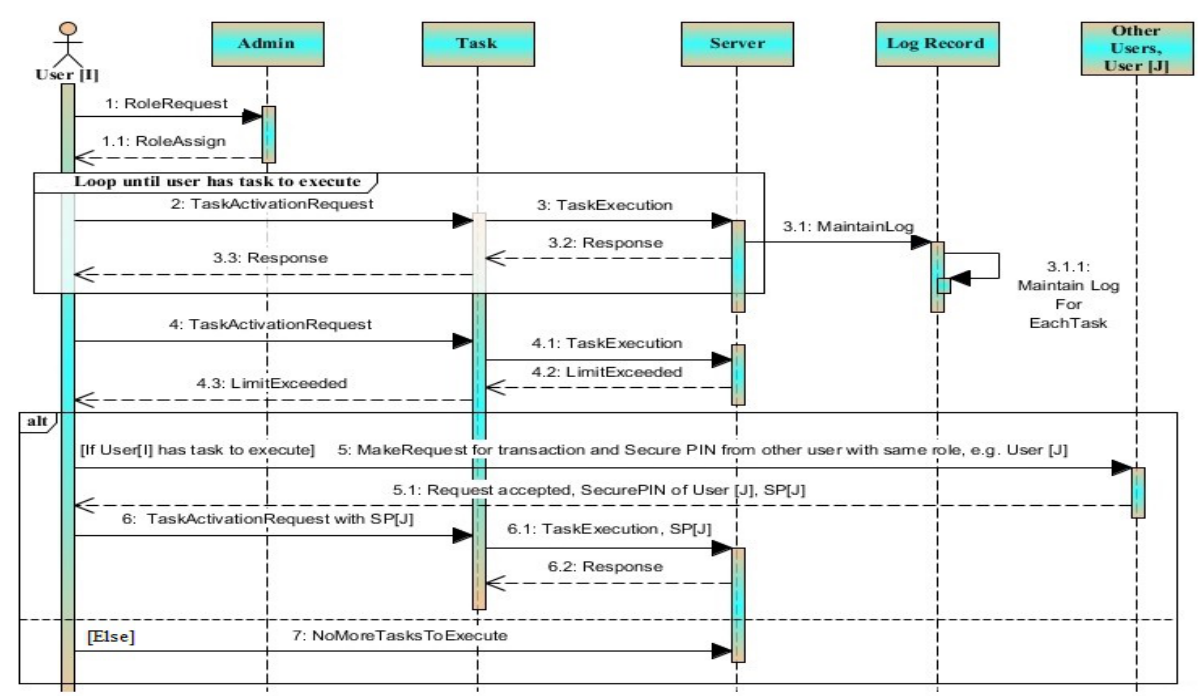
Figure 4. Sequence of events for EF-RBAC